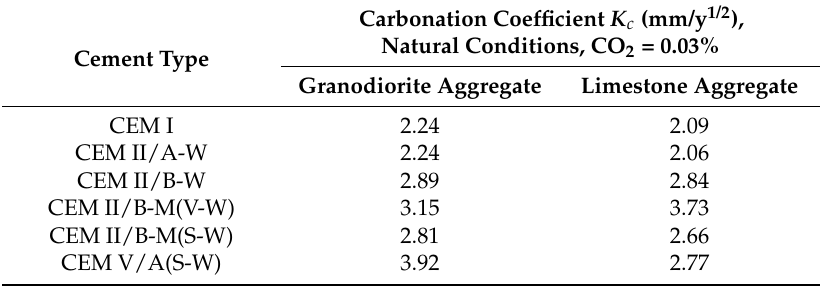
Table 5. Predicted K c values for natural environmental conditions (CO 2 concentration = 0.03%).